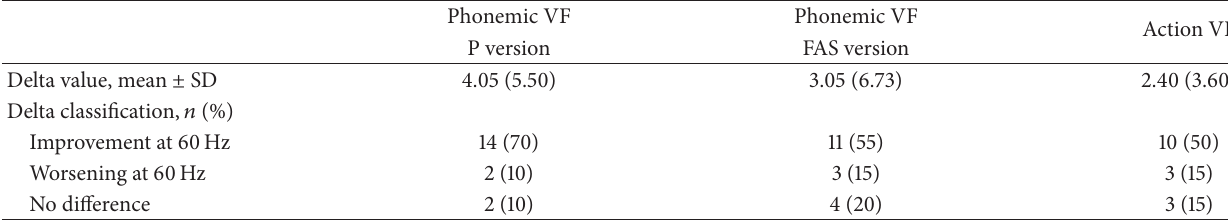
Table 5: Distribution of delta values for phonemic and action fluency